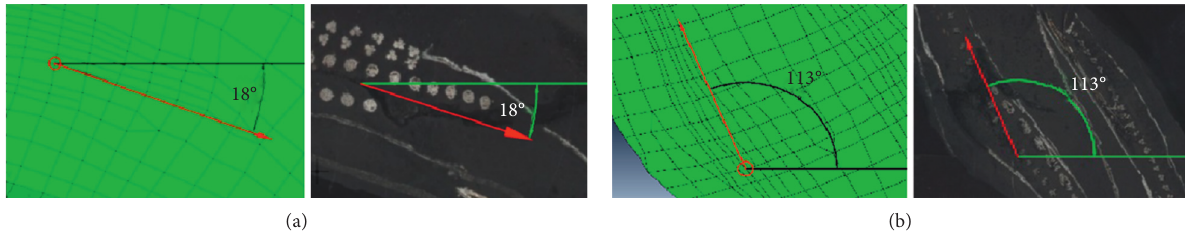
Figure 8: Concrete failure modulus. (a) Location of damage in Abaqus. (b) Failure form in the actual section. (a) Tire shoulder area. (b) Tire bead